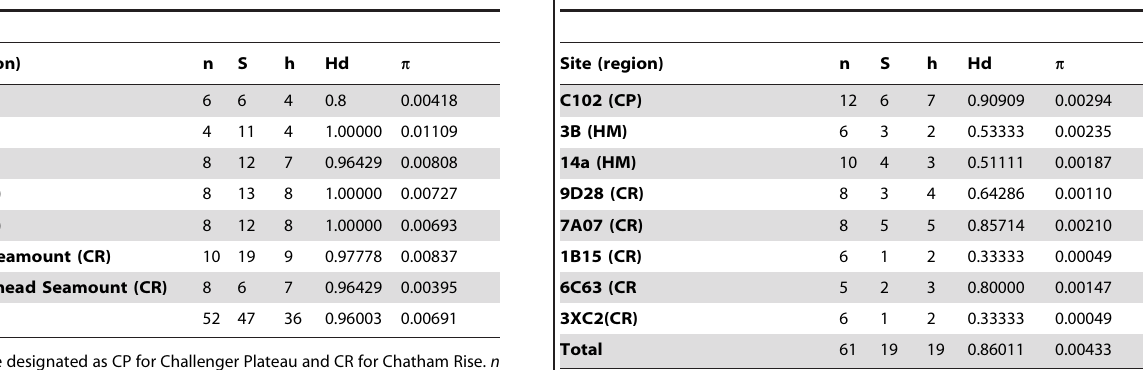
Table 3. Intra-population 16S diversity statistics for the quill worm, Hyalinoecia longibranchiata .